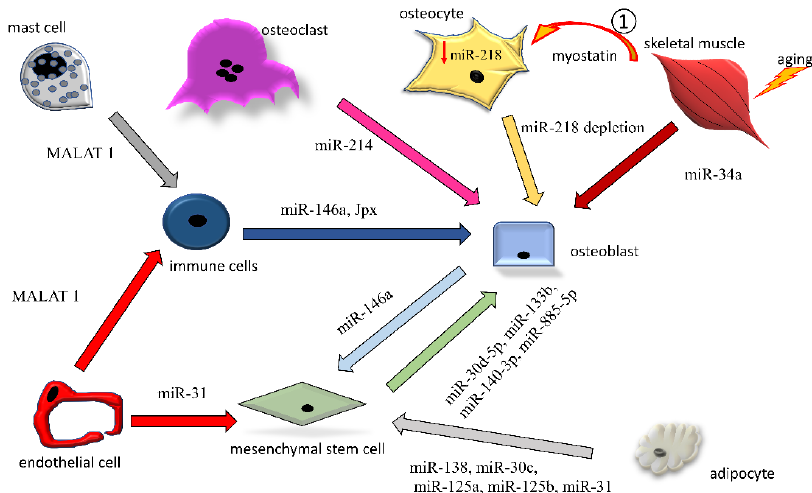
Figure 3. Intercellular exchanges of non-coding RNAs by means of EVs among bone-resident cells. Non-coding RNAs exerting osteopenic activity (increase in osteoclastogenesis or decrease in osteogenesis) are reported. Only ncRNAs directly found encompassed in EVs are reported in the figures. The arrows indicate the origin-to-destination direction between cells (donor to target cell). 1: soluble myostatin, released by aging muscle, a ff ects osteocytes in a paracrine manner, reacting with the drop in endogenous miR-218a ( ↓ miR-218a). The miR-218a-poor EVs released by the a ff ected osteocytes are taken up by osteoblasts, contributing to the perturbation of